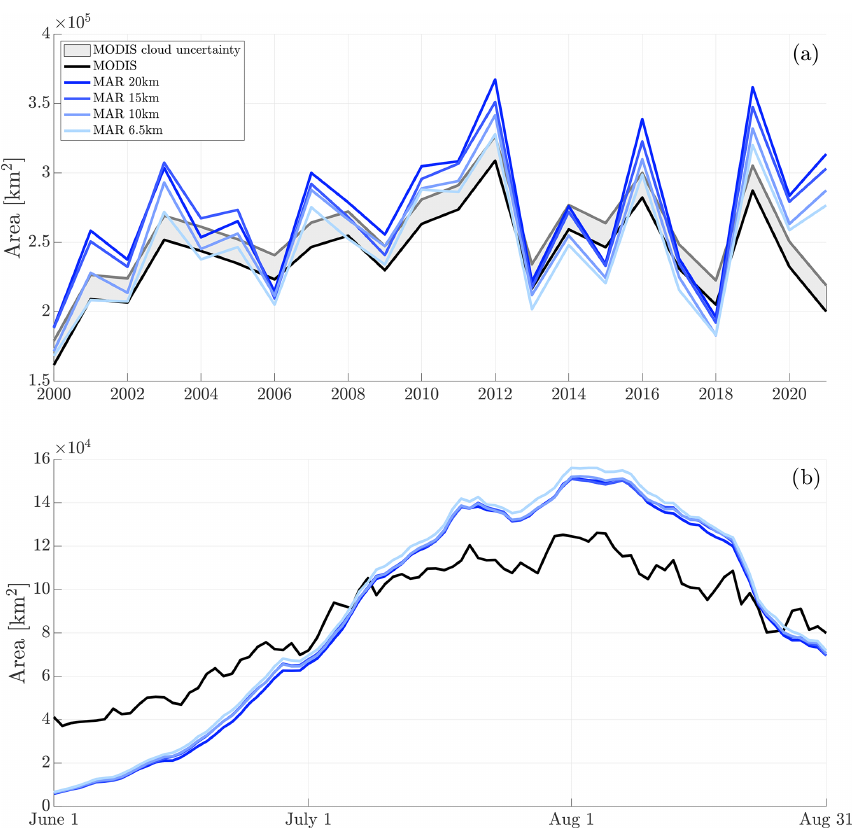
Figure 3. (a) Annual maximum bare-ice extent in 2000–2021, averaged over JJA, and (b) seasonal bare-ice extent in JJA, averaged over